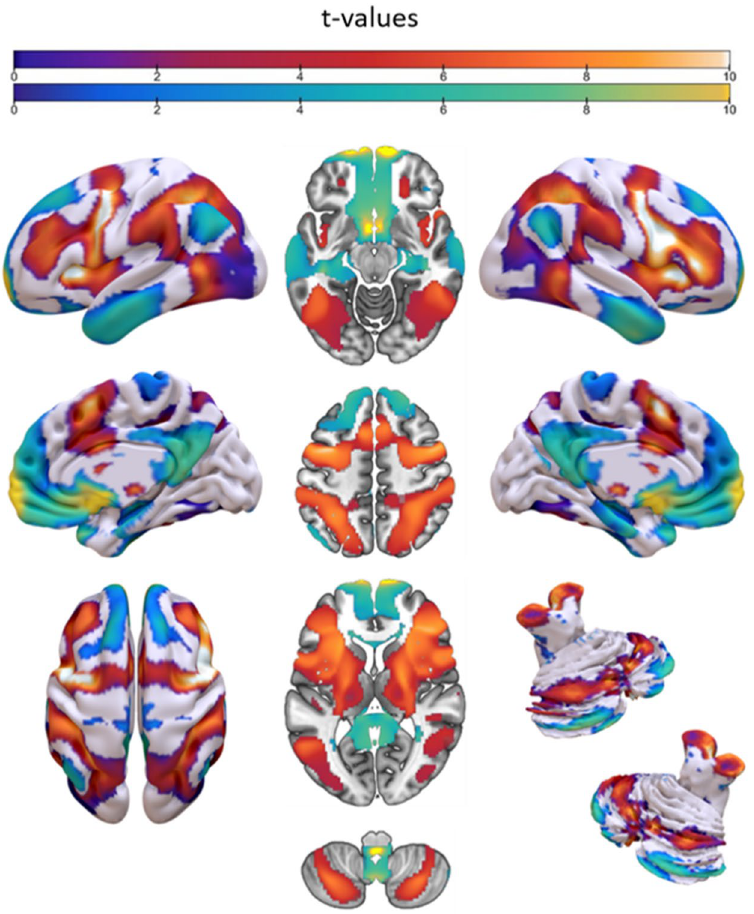
Figure 3. Surface, medial and cerebellar mapping of the SVC Consensus analysis revealing the “predictive network” for the condition of General Prediction. Note that this and the Prediction Violation areas overlap entirely. The network that shows the Prediction Encoding areas is presented in the Supplementary Materials (Fig. S2). Warm colors represent positive t-values (range: 4.37–14.17), cold colors are for negative t-values (range: 4.37–19.61), shown in arbitrary